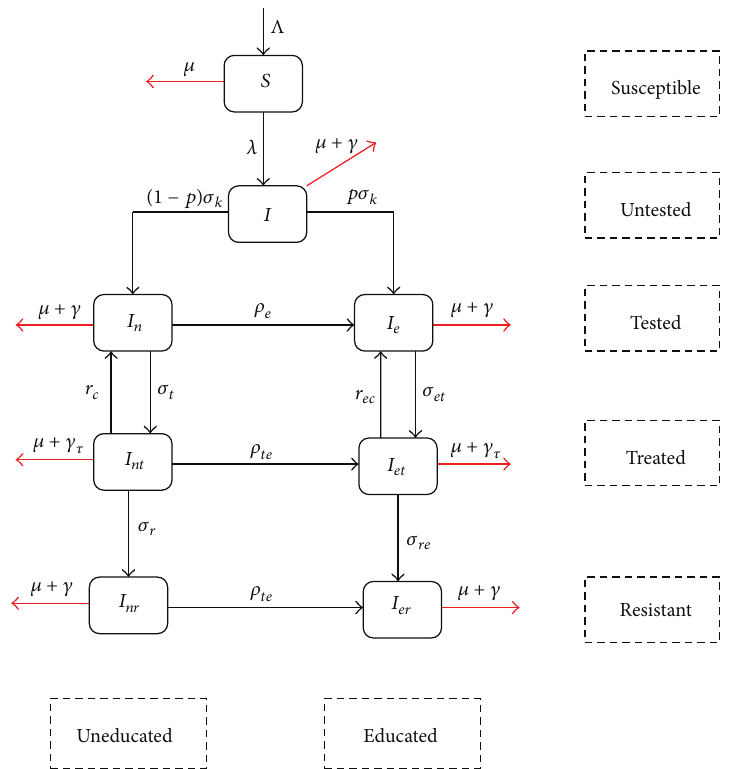
Figure 1: The full model: test and treat with education and drug resistance. Sexually active people are either susceptible or infected. Infected individuals are classified depending on knowing their status, being educated, being treated, and being drug resistant or not. We assume that the rate of appearance of new sexually active people is